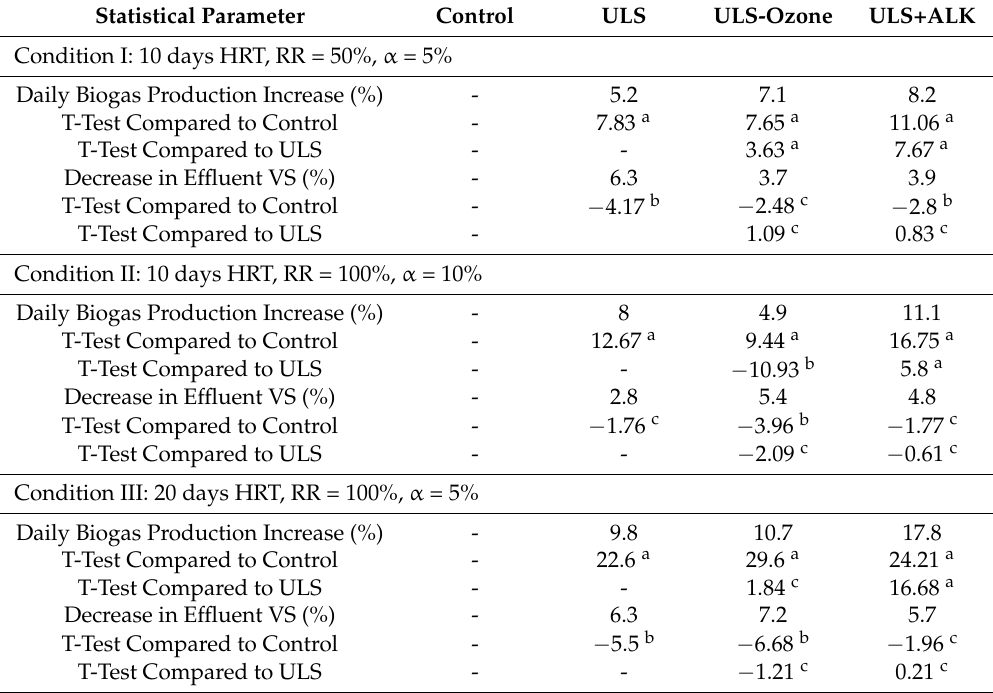
Table 4. Statistical analysis of the biogas production increase and effluent VS decrease due to post-treatment at different